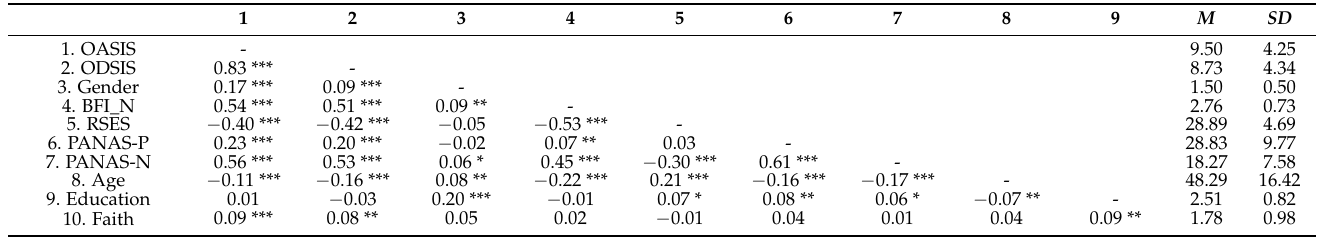
Table 3. Correlation table with means and standard deviations (Sample 4, n = 494).